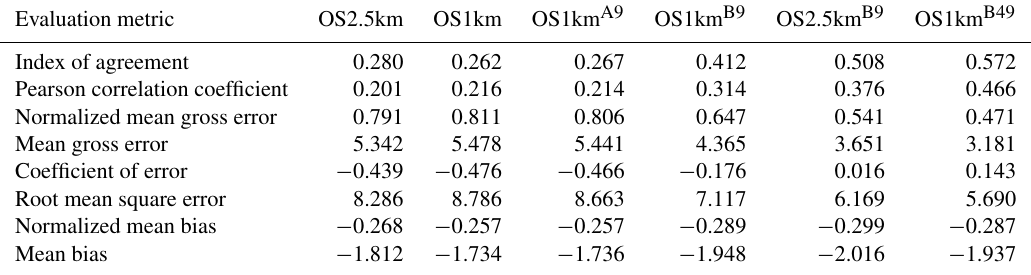
Table 5. Surface PM 2 . 5 observations to model comparison for entire simulation period (µgm − 3 , 3377 model–observation pairs). Evaluation